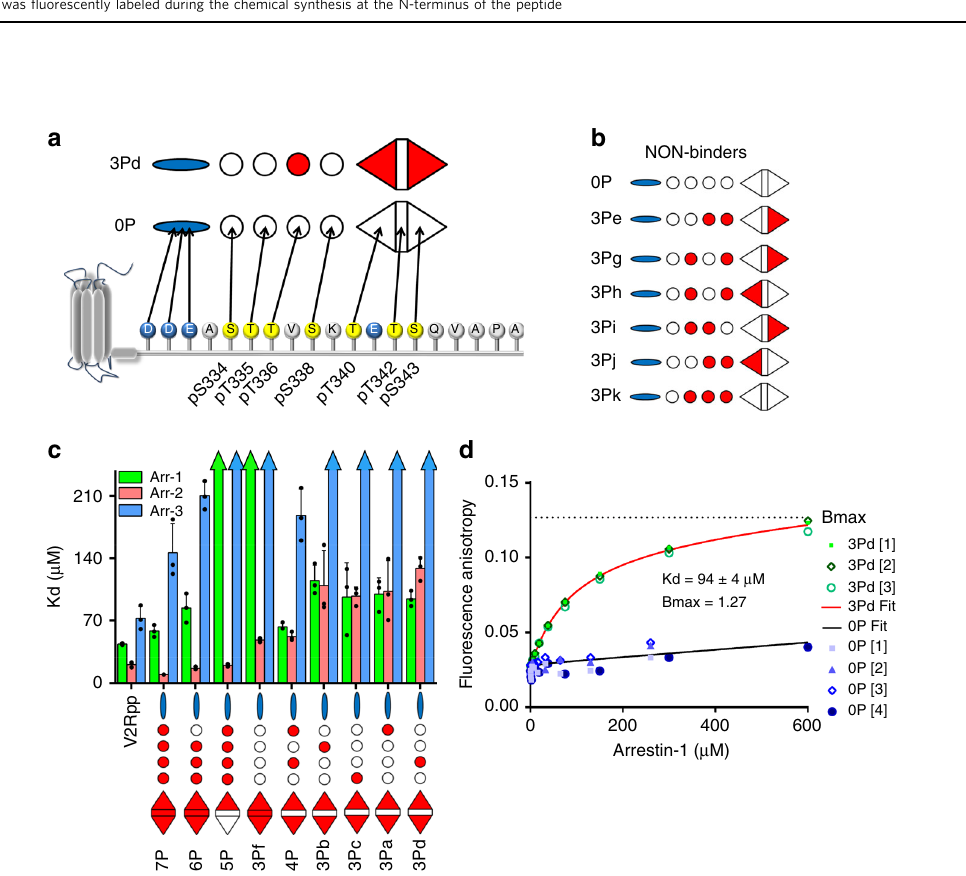
Fig. 2 Different phosphorylation patterns have varying abilities to bind arrestins. a Sequence of the bovine rhodopsin C-terminus and schematic illustration of the phosphorylation and charge pattern. In the sequence, potential phosphorylation sites are yellow, and negatively charged acidic residues are blue. In the schematic, the negatively charged patch is blue, nonphosphorylated sites are white, and phosphorylated sites are red. The shapes of the phosphorylation sites indicate their different functions, which were assigned in this study. b Peptides that did not show speci fi c binding or very weak binding to any tested arrestin isoform. c K d values of all speci fi c binders determined by fl uorescence anisotropy for arrestin-1, -2, and -3. Statistical analysis was performed by ANOVA analysis and these values are reported in Supplementary Information Tables 1, 2 and 3. d Fluorescence anisotropy arrestin-1 binding curves of nonphosphorylated peptide 0P (different shades of blue) and the tri-phosphorylated peptide 3Pd (different shades of green). Each titration was repeated three or four times. Fits of the individual binding curves were used to obtain error bars shown in part ( c ) and Table 2 (Source data are provided as a Source Data fi